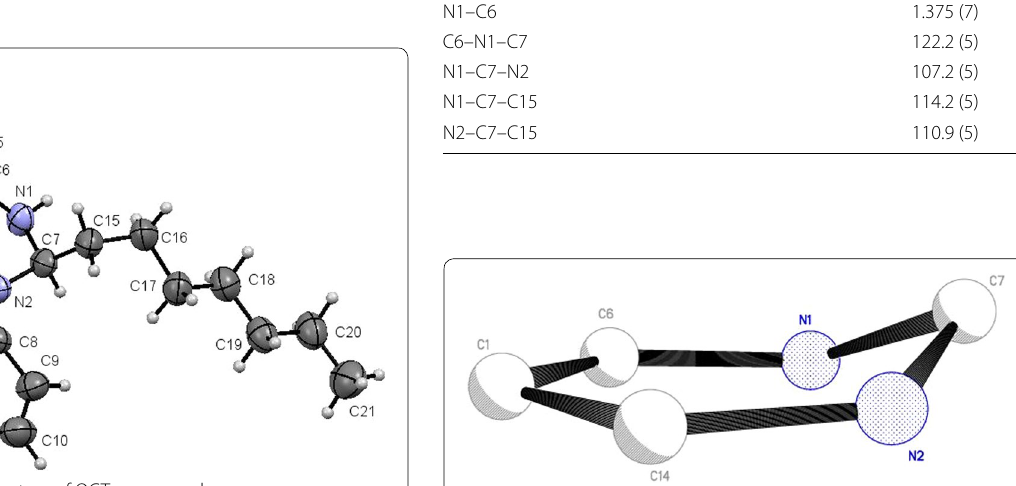
Fig. 10 The conformation of diazine ring of OCT